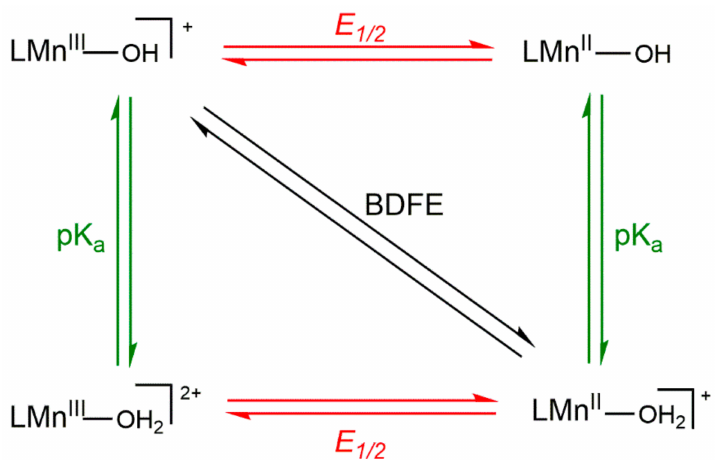
Scheme 3. Thermodynamic Square Scheme for Decomposing the O − H BDFE of a Mn III -OH/Mn II - OH 2